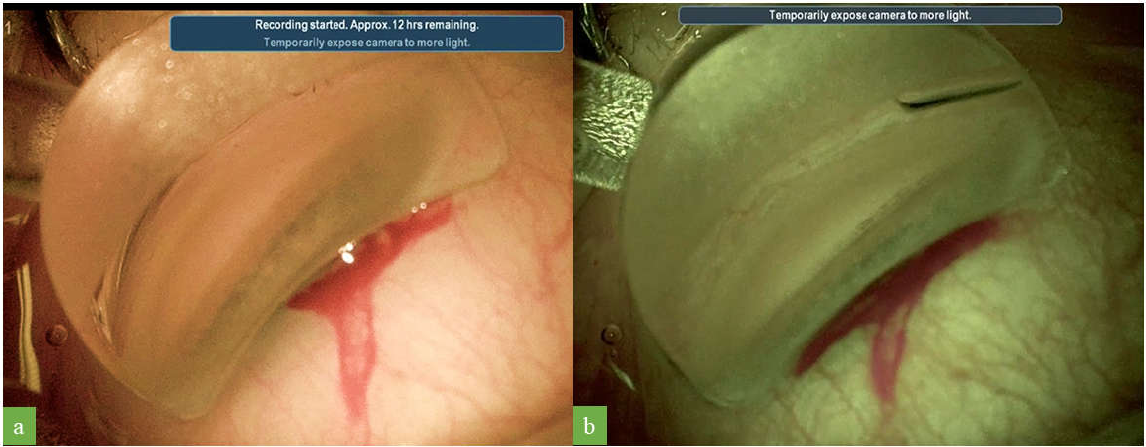
Figure 3. Images obtained during surgical gonioscopy with standard colors ( a ) and with the cyan filter with 60% color saturation ( b ). This filter provided a good level of contrast, enhancing visualization of the pigmentation of the trabecular meshwork and Schlemm’s canal.